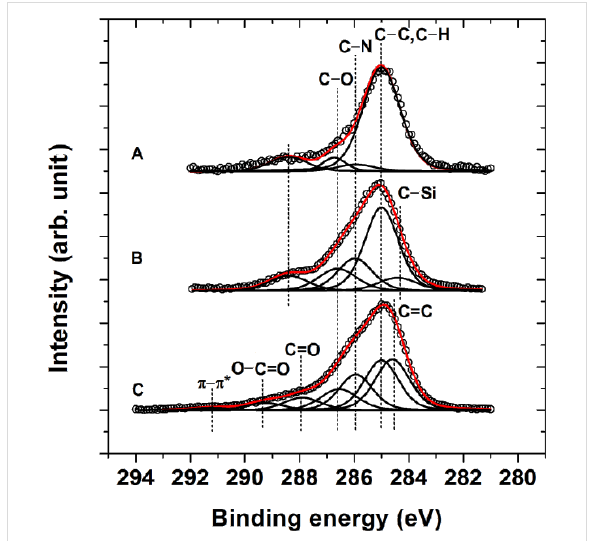
Figure 3: High resolution C 1s XPS spectra of neridronate (A), APTES siloxane (B) and PDA (C) films on the surfaces of activated flat tita- nium substrates (black). The unfilled circles represent the measured data, while the red lines represent the fitted data. The individual contri- butions to the fitted data of different functional groups present in the films are represented with black